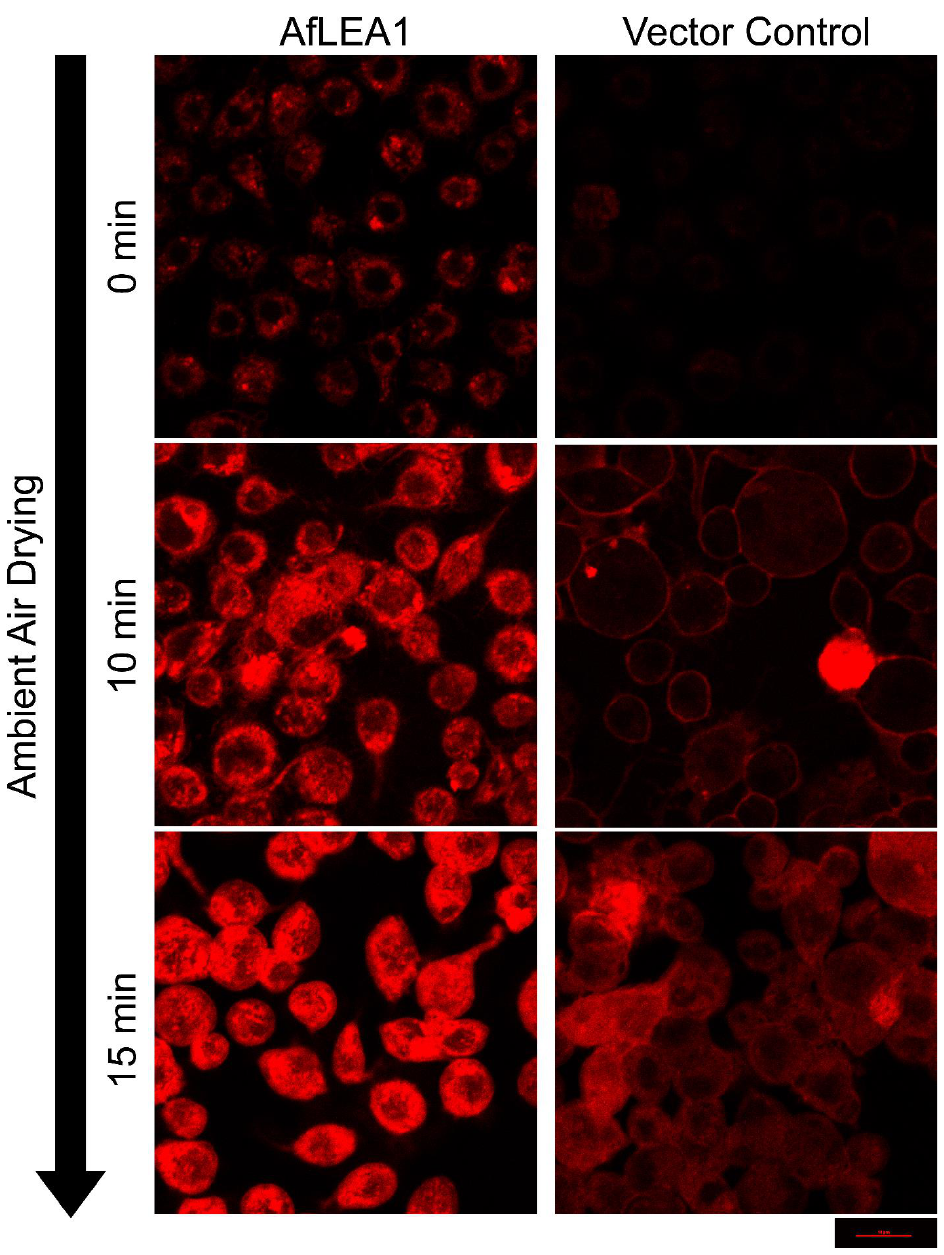
Figure 13. Af LEA1, when ectopically expressed in Kc167 cells, increases the intracellular viscosity, improves cellular integrity, and reduces plasma membrane fusions during desiccation. Cells ectop- ically expressing untagged Af LEA1, or the vector control, were stained for 2 min in 200 µL DPBS containing 0.1 µg/mL Nile Red (9-diethylamino-5H-benzo[a]phenoxazin-5-one). Cells were desic- cated through evaporative water loss at ambient relative humidity. Fluorescence intensities are rel- ative among all images.